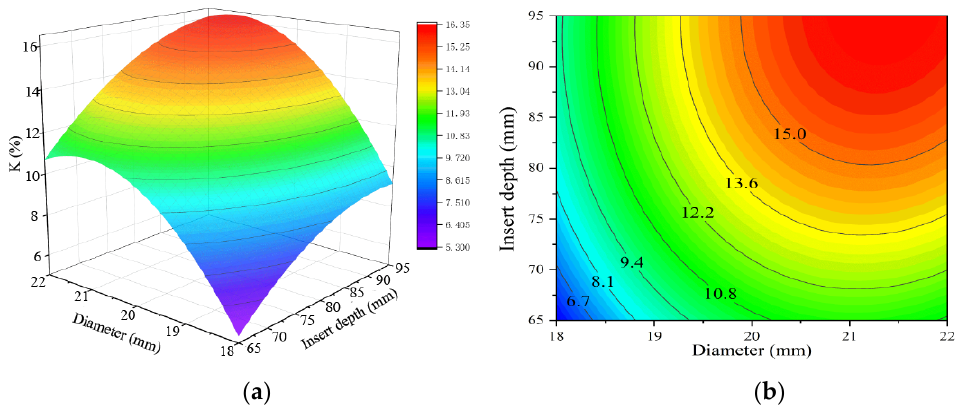
Figure 16. Response surface diagram. ( a ) Three-dimensional response diagram ( b ) Response surface relationship contour map.